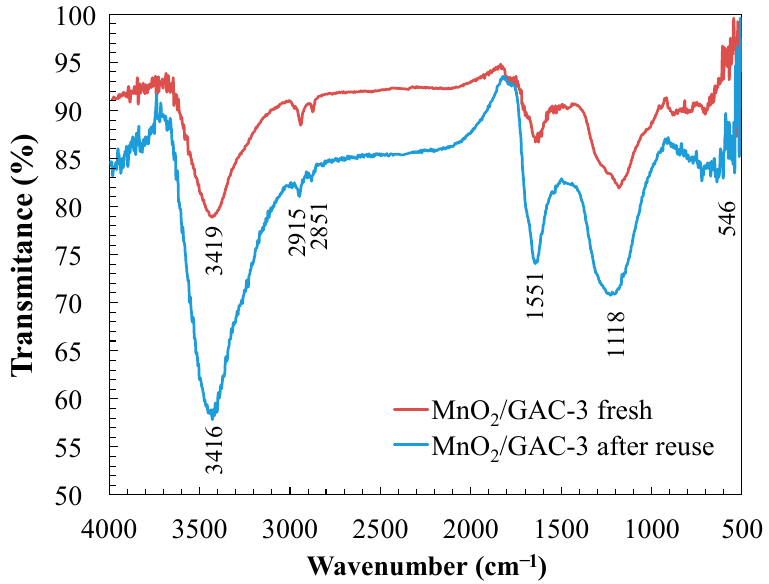
Figure 16. Infrared spectrum of MnO 2 /GAC-3 before and after six cycles of reuse during the photo- catalytic process for ANI and BTH degradation. Experimental conditions: C 0 = 12.0 mg L − 1 ; pH = 9.0; m CAT = 0.9 g L − 1 ; Irradiation dose = 155.8 W m − 2 ; T = 26 °C.